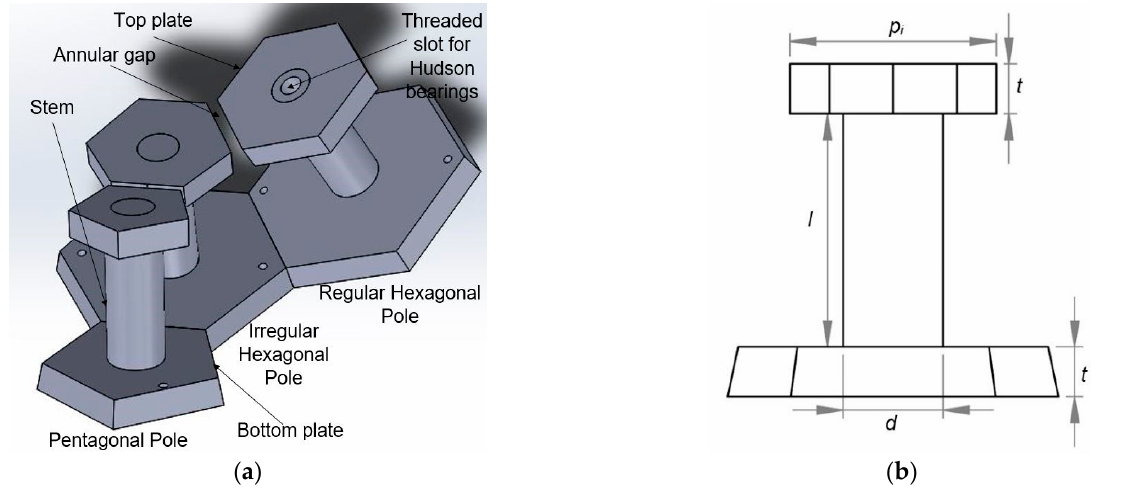
Figure 2. Stator pole geometry: ( a ) solid model of three adjacent stator poles showing annular gaps between top plates and direct contact between bottom plates; ( b ) pentagonal pole dimensions: top and bottom plate thickness t , stem length l , stem diameter d and major diameter of polygon face.